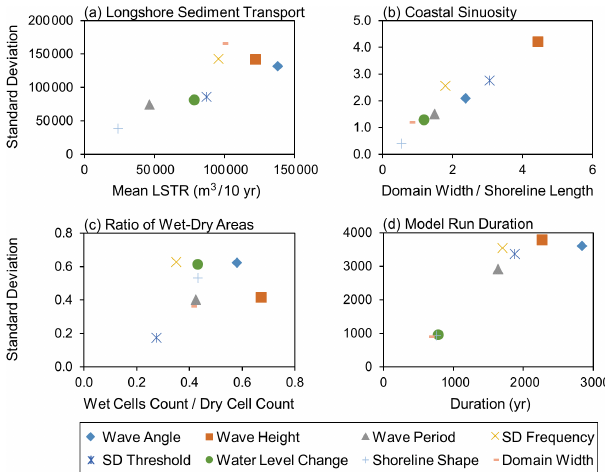
Figure 9. The mean and standard deviation of results from the input factors, according to the four behavioural indices labelled (a) – (d)